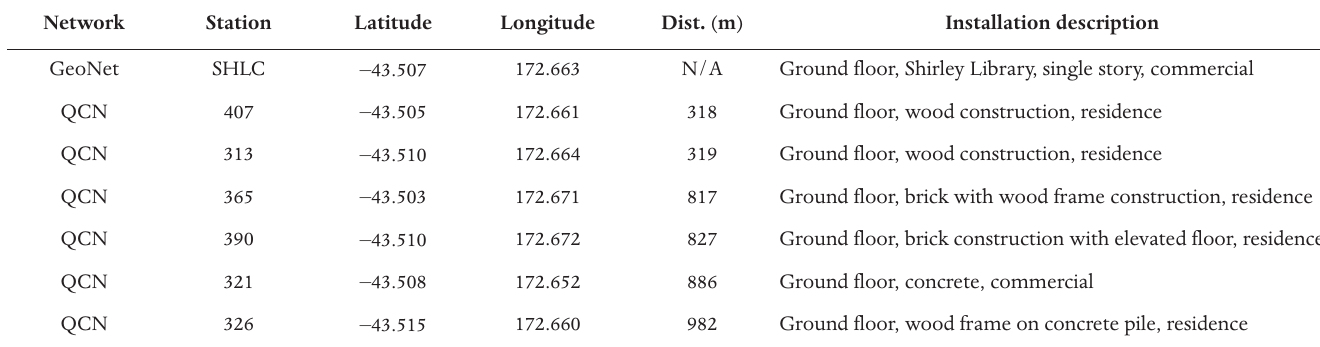
Table 3. Location and installation data for the QCN array near the GeoNet station SHLC.